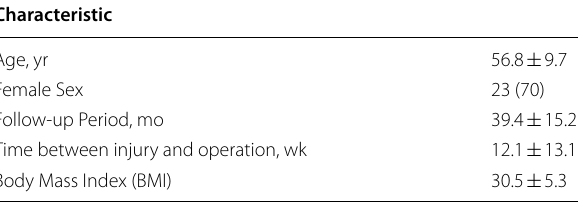
Demographics are represented as the mean Female Sex expressed as n (%)